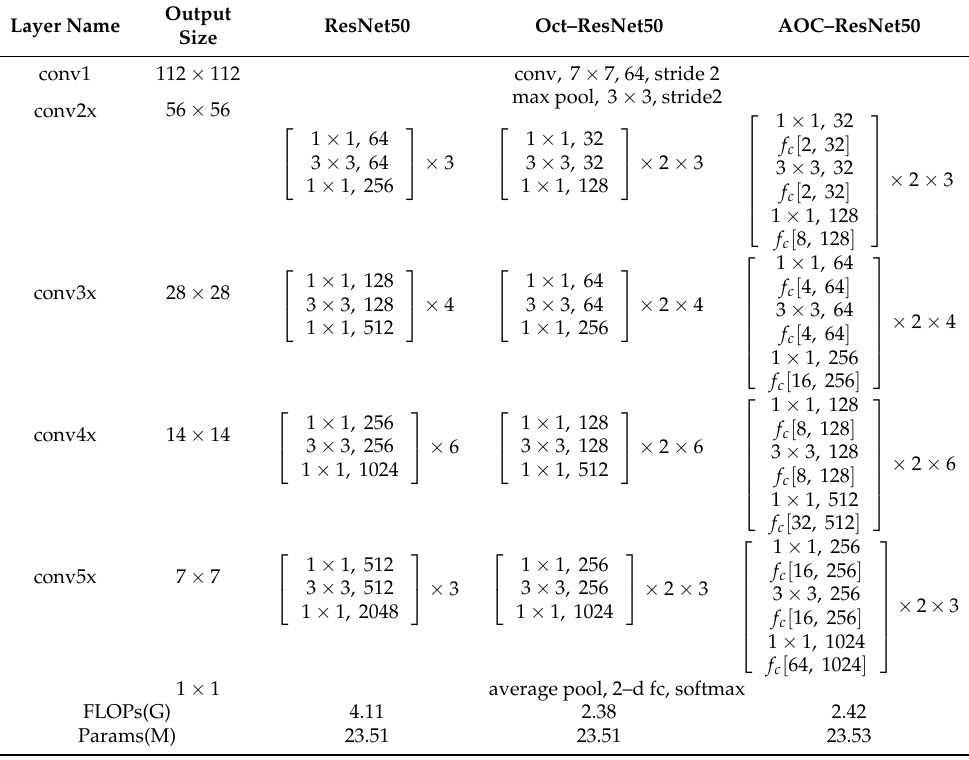
Table 2. Comparison of three network structures.